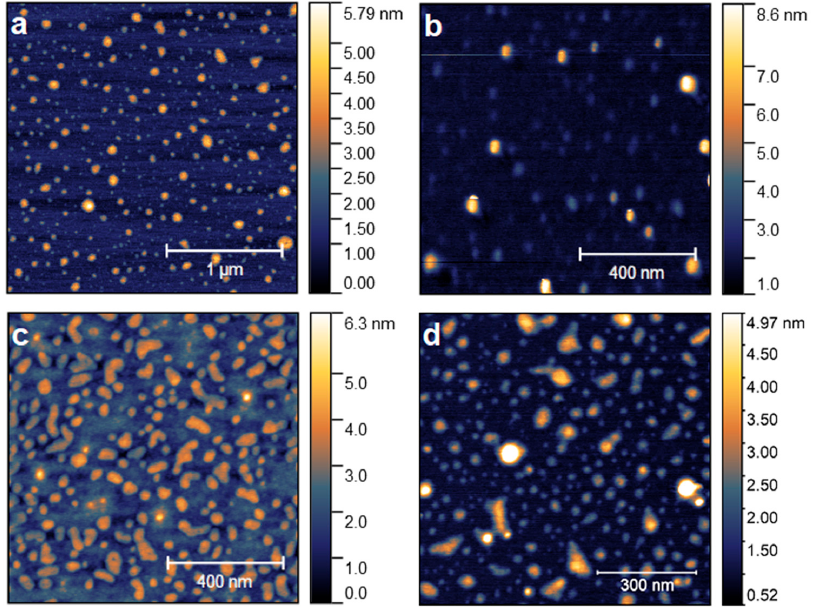
Figure 1. Atomic force microscopy (AFM) images of LEA CDs ( a ), GEA CDs ( b ), CAU CDs ( c ) and LU CDs ( d ).